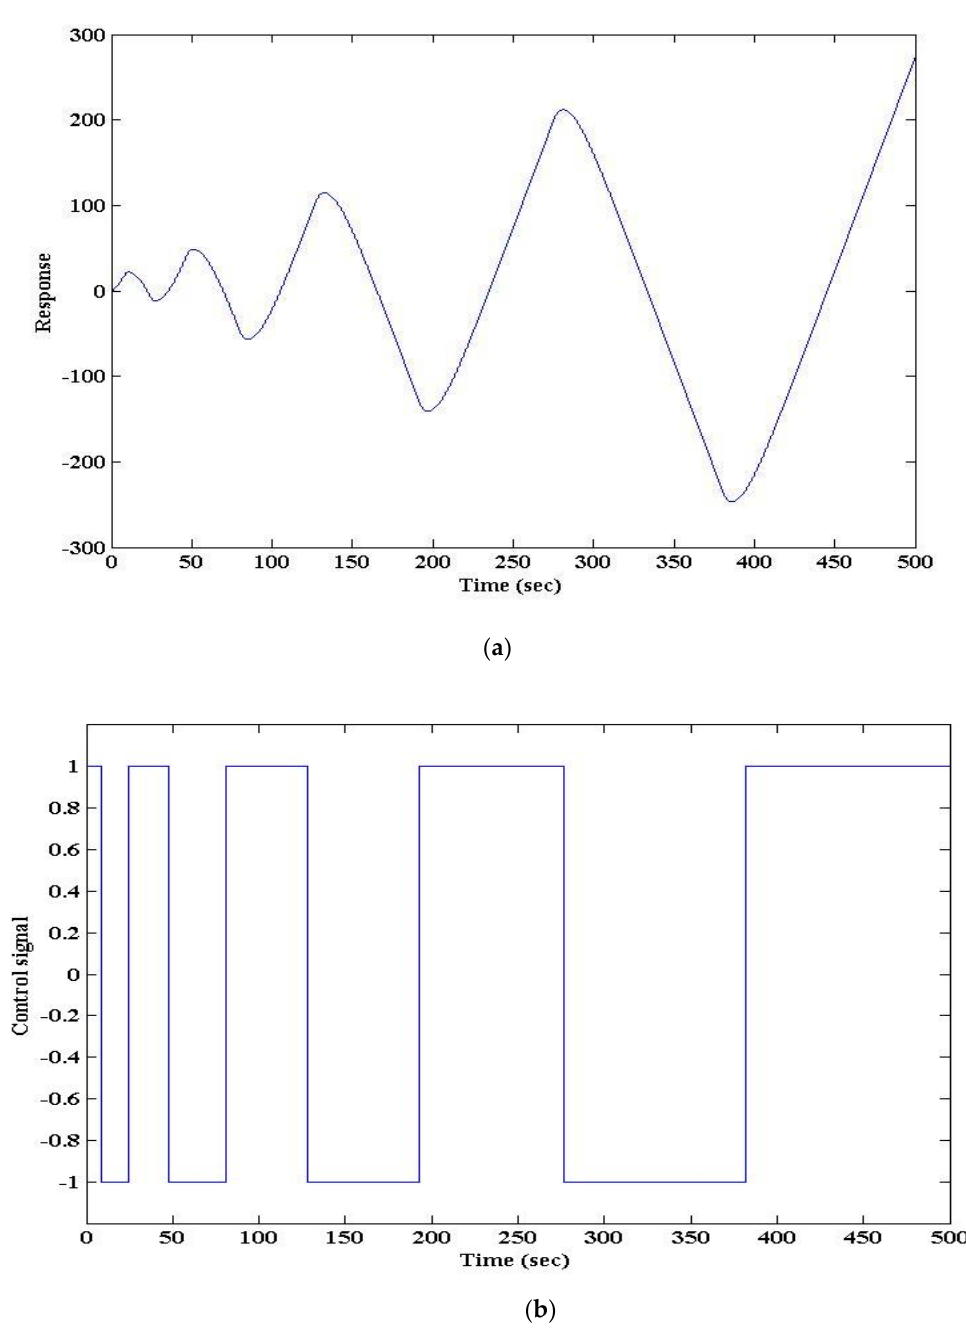
Figure 6. Closed-loop system without anti-windup controller. ( a ) Nominal closed-loop system for a step reference r ( t ) = 10 × 1( t ), ( b ) saturated control input.